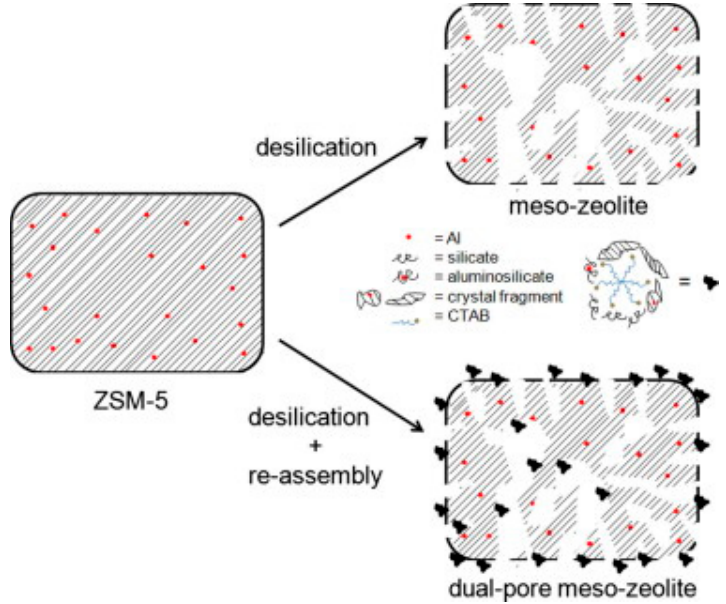
Figure 7. Schematic illustration of the preparation of mesoporous zeolite by means of desilication (upper right) and desilication/reassembly (lower right) [101]. Copyright (2012), with permission from Elsevier.